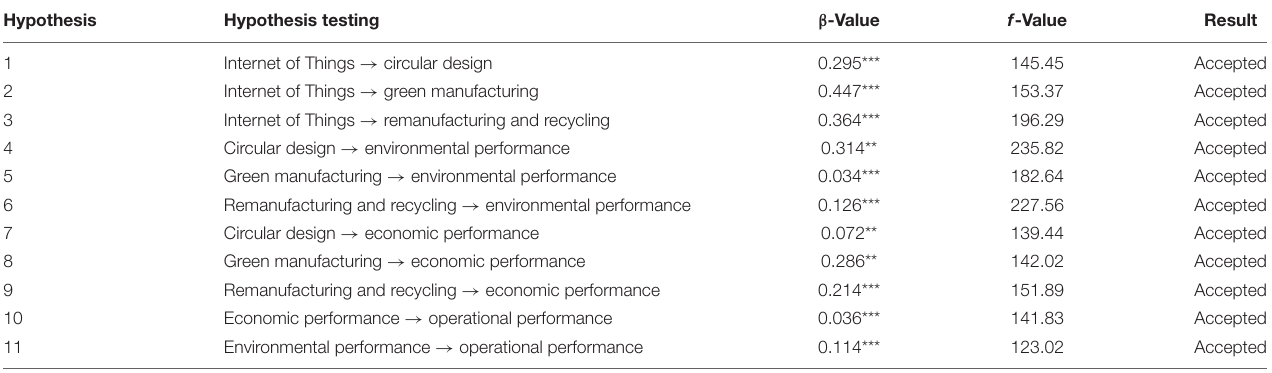
TABLE 11 | The results of hypothesis testing.